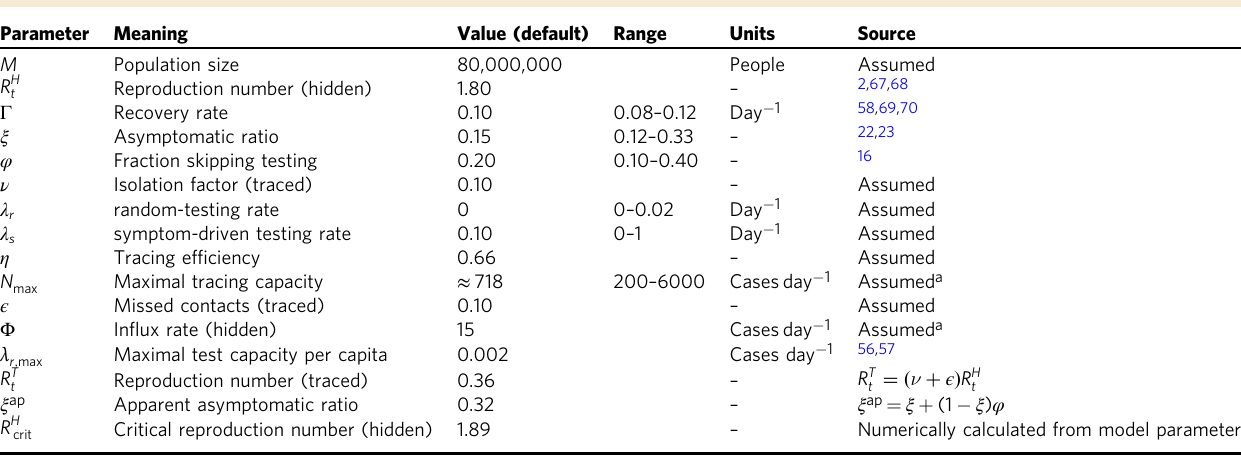
Critical reproduction number (hidden) 1.89 Numerically calculated from model parameters a Chosen for a country with a population of M = 80 ⋅ 10 6 . See “ Methods ” for